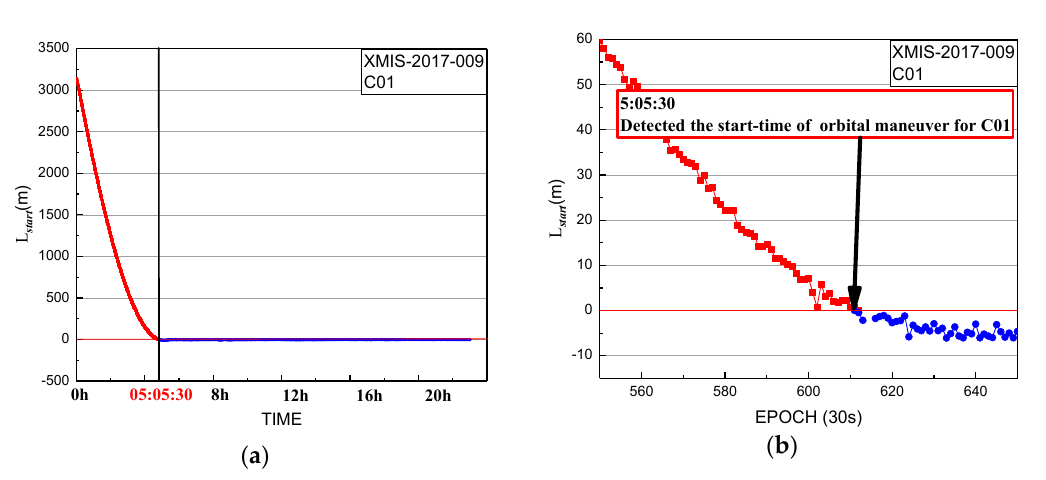
Table 1. Thresholds of orbital maneuver detection for XMIS in 2017 (unit: meter).